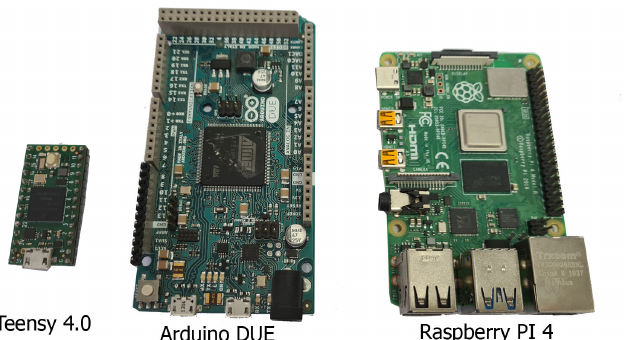
Figure 6. Devices used in the test: Teensy 4.0 ( left ), Arduino DUE ( center ) and Raspberry Pi4 ( right ). Source: Own